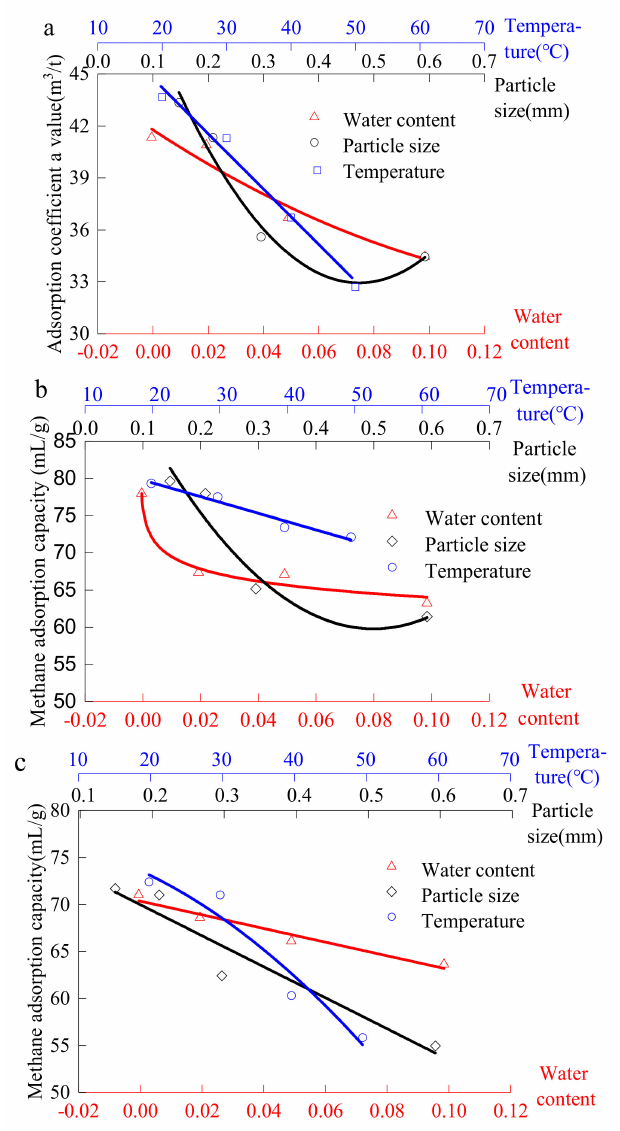
Figure 10. Relationship between the amount of methane adsorption and di ff erent factors of testing materials: ( a ) Aiweiergou #1890 working face coal sample; ( b ) Activated alumina; ( c ) Silica